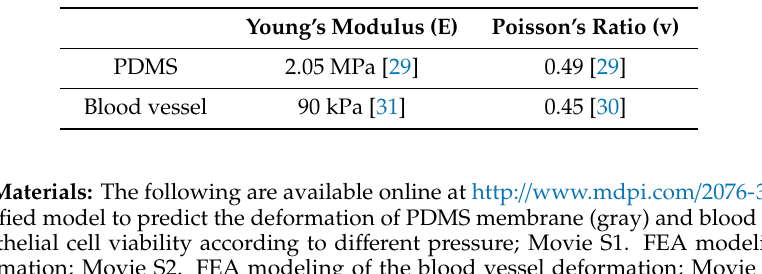
Figure S1. Simplified model to predict the deformation of PDMS membrane (gray) and blood vessel (dark red); Figure S2. Endothelial cell viability according to di ff erent pressure; Movie S1. FEA modeling of the PDMS membrane deformation; Movie S2. FEA modeling of the blood vessel deformation; Movie S3. The e ff ect of compressive stress to 3D perfusable microvessel network: microbead flowing